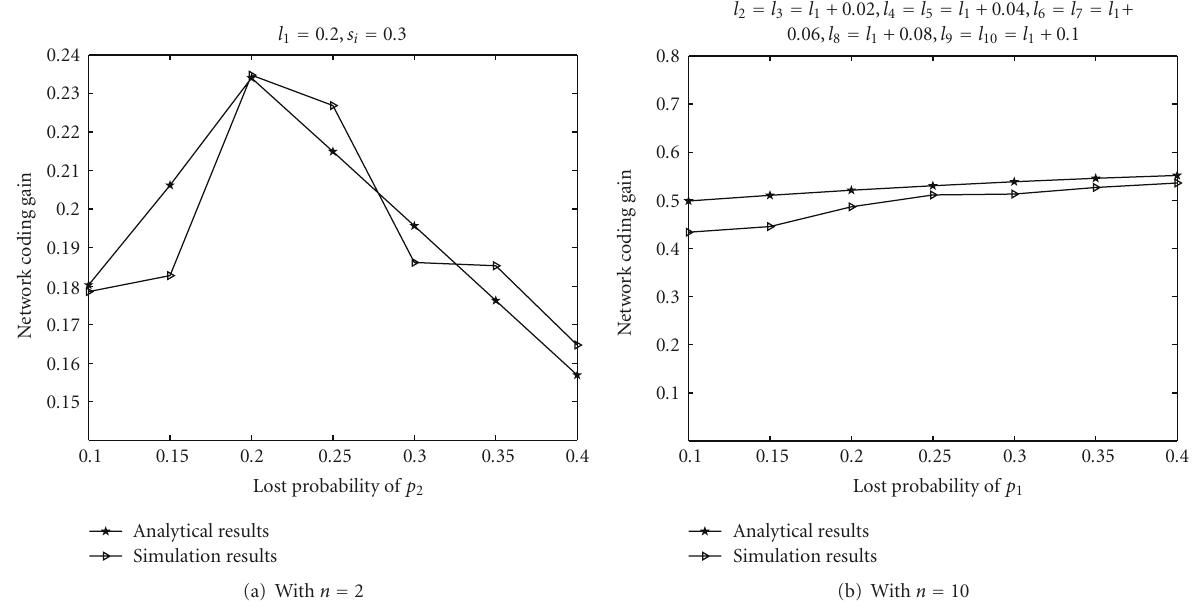
Figure 6: Network coding gain versus packet loss probability of sensor.